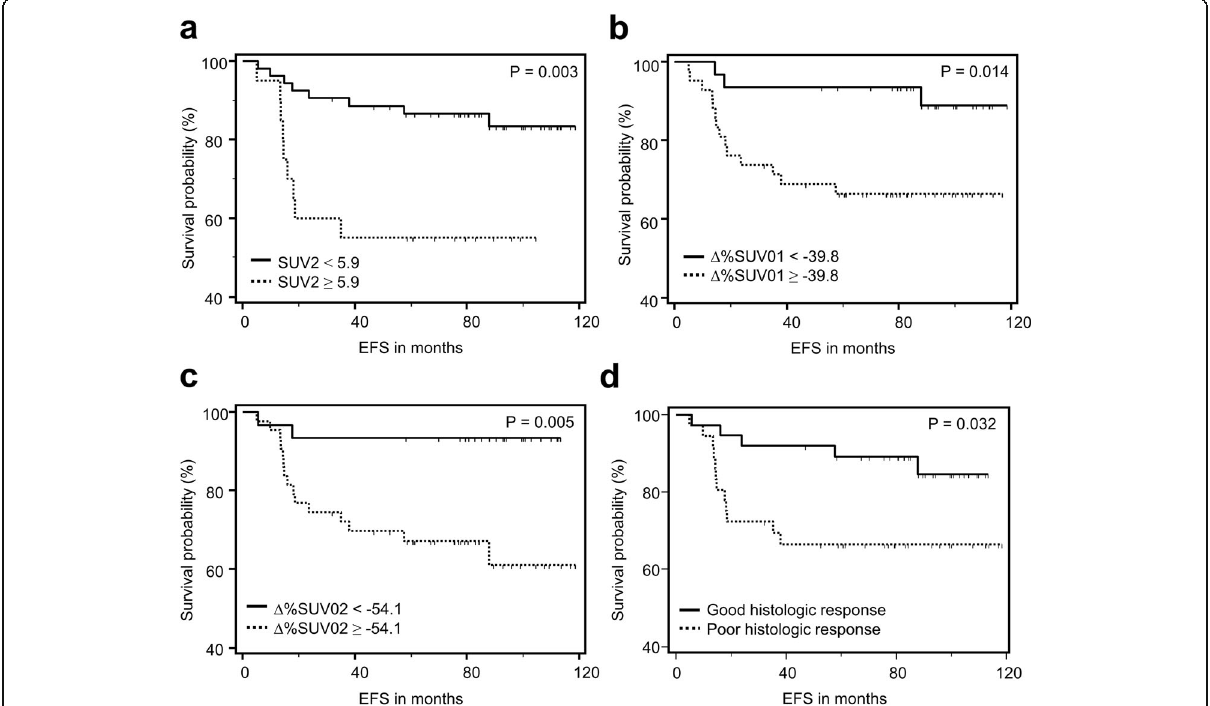
Fig. 2 Kaplan-Meier survival curves of the events-free survival depending on the [ 18 F]FDG PET parameters including SUV2 ( a ), Δ %SUV01 ( b ), Δ %SUV02 ( c ), and histologic response ( d ). SUV2 is the SUV max of the primary tumor after completion of neoadjuvant chemotherapy. Δ %SUV01 is the percentage change in SUV max between baseline and interim of [ 18 F]FDG PET. Δ %SUV02 is the percentage change in SUV max between baseline and post-therapy of [ 18 F]FDG PET/CT